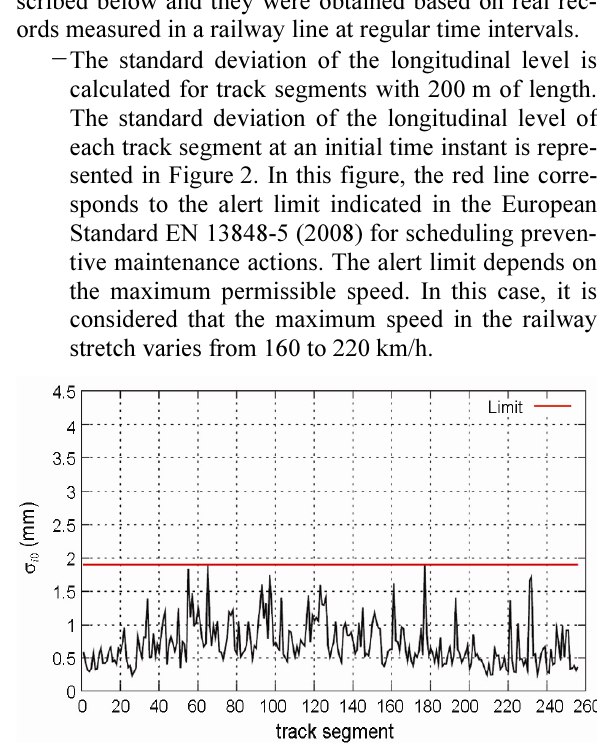
Fig. 2. Standard deviation of the longitudinal level of each track segment at the initial time